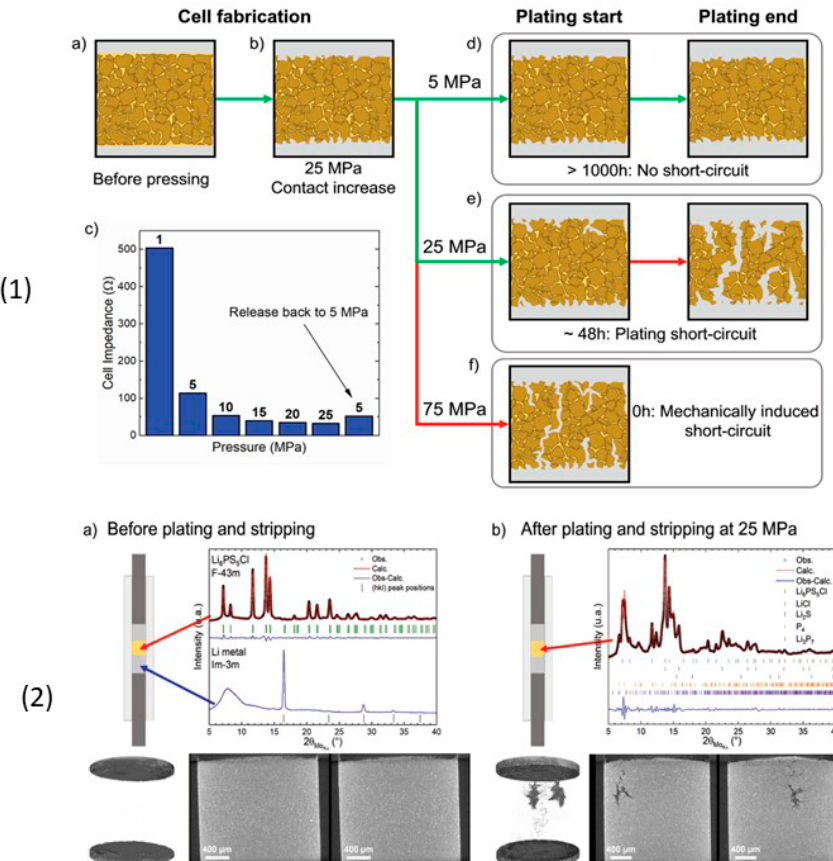
Figure 8. ( 1 ) Schematic of the e ff ect of the stack pressure on the short-circuiting behavior of Li metal solid-state batteries. ( a ) During cell fabrication, the contact between the electrolyte and Li metal was poor before the Li metal was pressed on the electrolyte pellet. ( b ) Pressing the Li metal at 25 MPa allowed the proper wetting of the electrolyte and ( c ) induced a large decrease in the impedance of the symmetric cell even when the pressure was later decreased to 5 MPa. ( d ) Plating and stripping at a stack pressure of 5 MPa. Li did not creep inside the solid-state electrolyte (SSE) pellet, and therefore, the cell cycled for more than 1000 h. ( e ) At a stack pressure of 25 MPa, Li slowly crept between the grains of the SSE and plating occurred on the dendrites, which eventually short-circuited the cell after 48 h. ( f ) When the stack pressure was too high, Li crept through the electrolyte and formed dendrites that mechanically short-circuited the cell. ( 2 ) Schematic of the cell used for X-ray tomography and X-ray di ff raction (XRD) analyses; profile matching of the XRD and X-ray tomography patterns of a Li | Li 6 PS 5 Cl | Li symmetric cell cycled under a stack pressure of 25 MPa ( a ) before plating and stripping and ( b ) after short-circuiting. Before plating and stripping, only Li 6 PS 5 Cl was detected in the electrolyte and Li metal was present on both sides. The X-ray tomography pictures confirmed that Li was not present in the electrolyte. After the cell short-circuited, several additional phases, mainly Li 2 S, LiCl, P 4 , and Li 3 P 7 , were detected inside the electrolyte; these were components of the solid electrolyte interphase that formed when Li was in contact with Li 6 PS 5 Cl. The X-ray tomography pictures illustrate that a large quantity of low-density dendrites formed in the electrolyte. Reproduced with permission from [201]. Copyright 2020